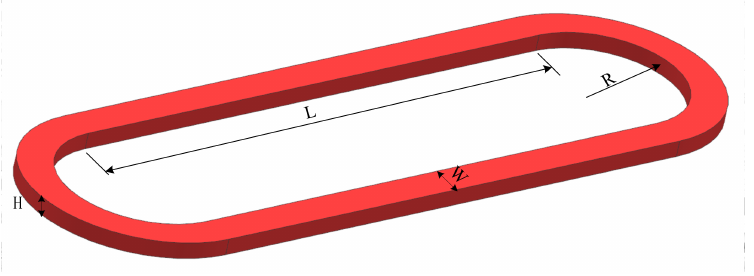
Figure 3. Sketch of a racetrack high temperature superconducting (HTS)